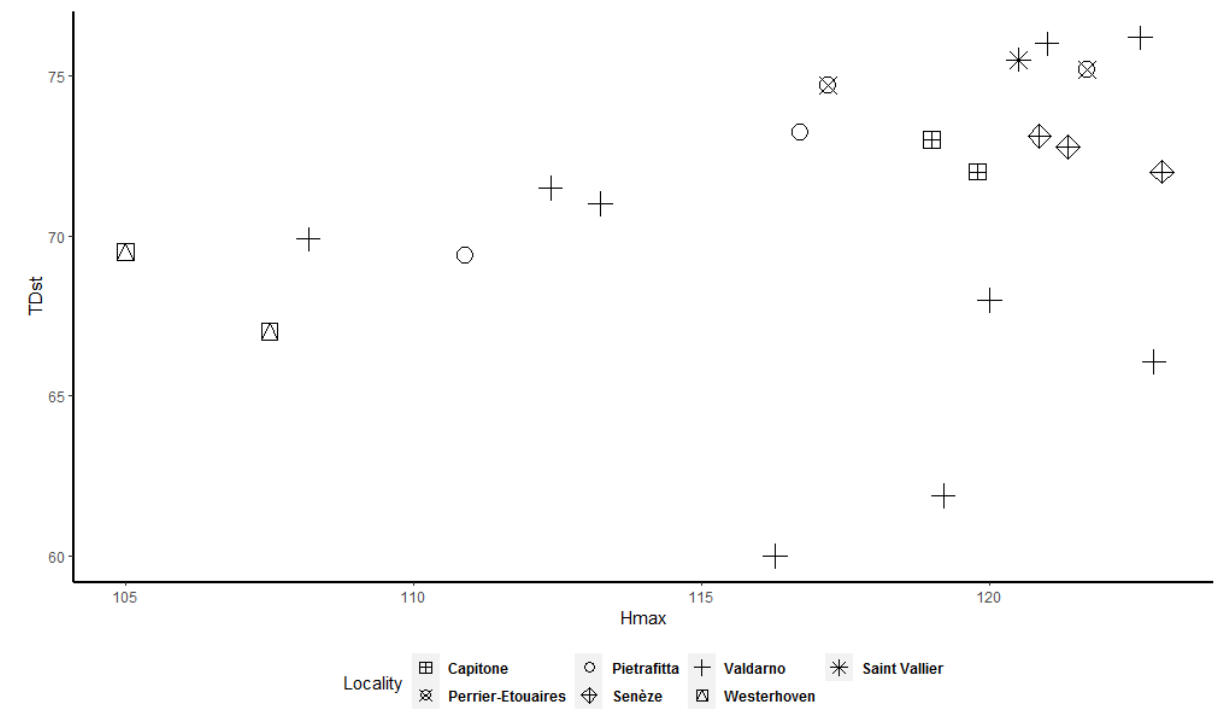
Figure 9. Scatterplot between the maximum transverse diameter (Tdmax) and the maximum height (Hmax) of astragalus.